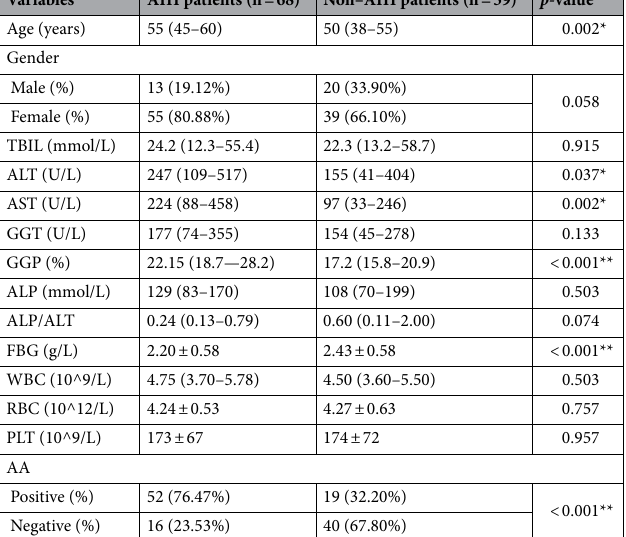
Table 2. Comparison of AIH and non-AIH in the training set (n = 127). Data are shown as the means ± SD, median (interquartile range) or frequencies (%). TBIL total bilirubin, ALT alanine aminotransferase,